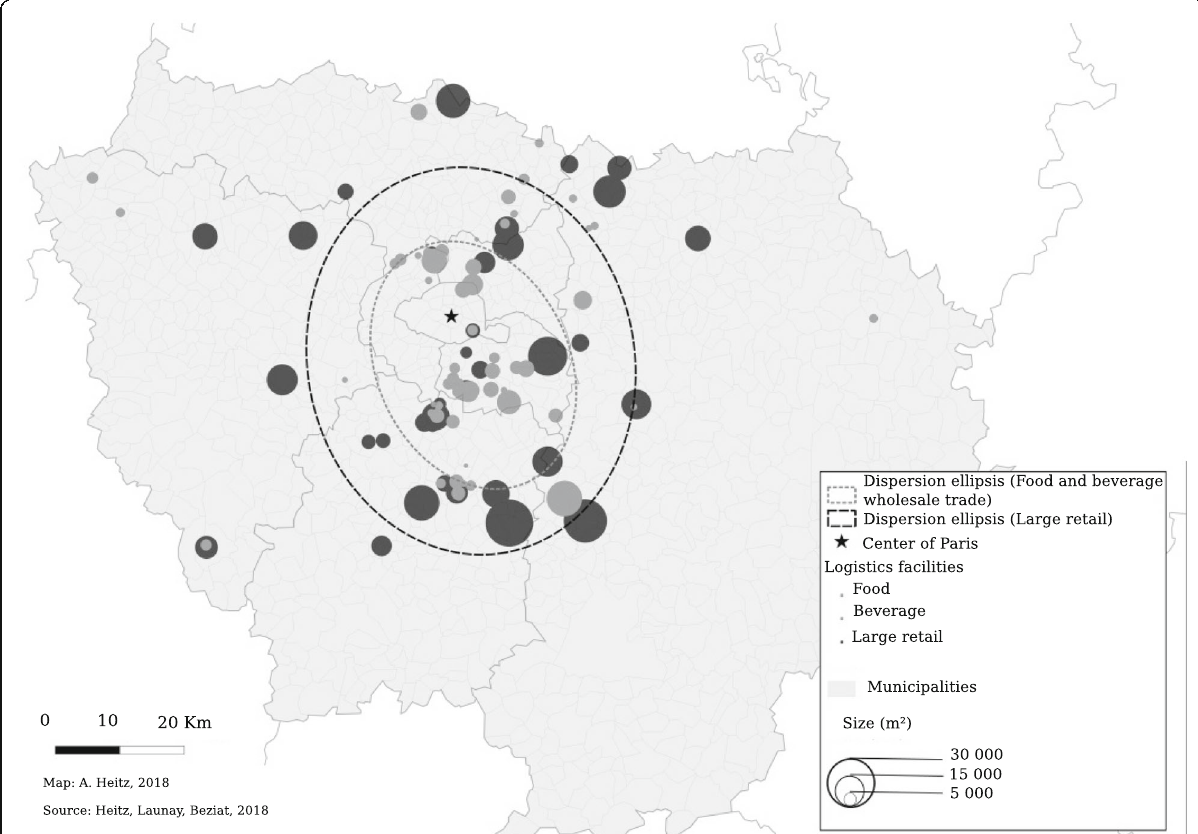
Fig. 4 Location of wholesale facilities and distribution centers in the Paris